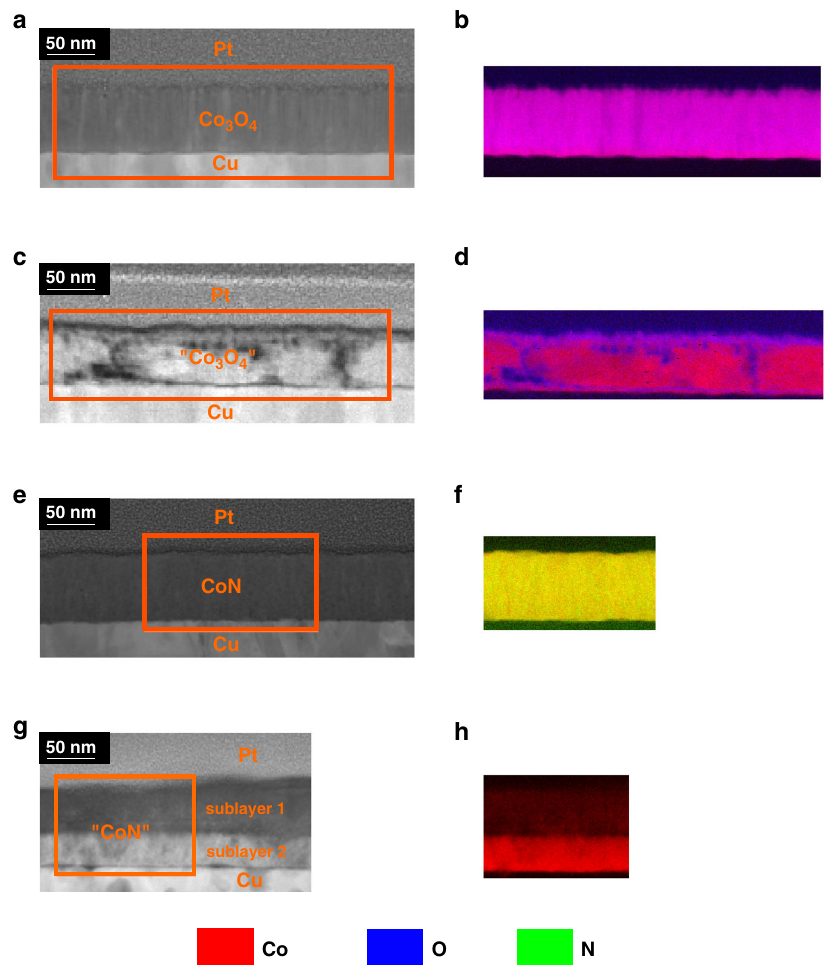
Fig. 3 Compositional characterization by high-angle annular dark- fi eld scanning transmission electron microscopy (HAADF-STEM) and electron energy loss spectroscopy (EELS). a – b , c – d , e – f , and g – h are the HAADF-STEM images and corresponding elemental EELS mappings of the areas marked in orange, respectively, of the as-prepared Co 3 O 4 fi lm, Co 3 O 4 fi lm subjected to a − 50 V for 75 min, as-prepared CoN fi lm and CoN fi lm subjected to a − 50 V for 75 min, respectively. The colors corresponding to each element for the EELS analyses are depicted at the bottom of the fi